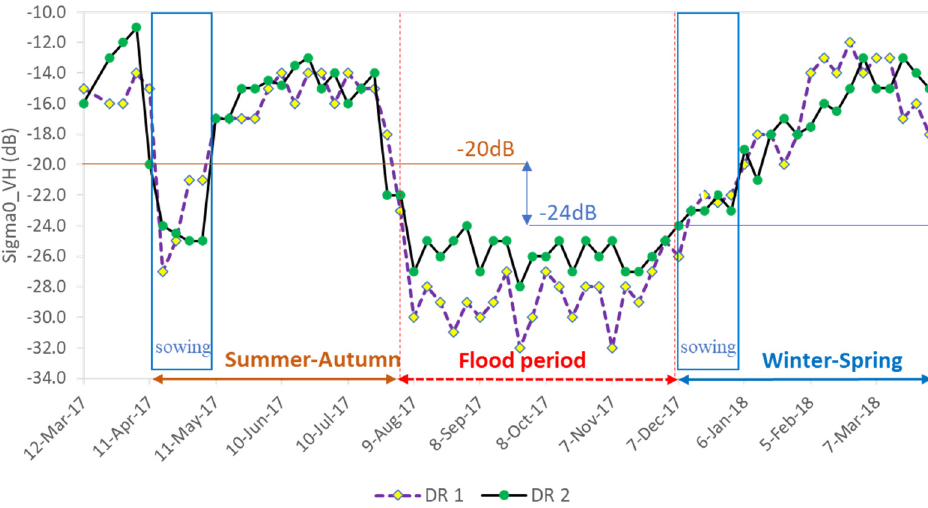
Figure 6. Sentinel-1 backscatter of crop phenology at two random samples, DR1 (10.47°N and 105.17°E) and DR2 (10.63°N and 105.51°E), cultivating two rice seasons a year (summer-autumn and autumn-winter seasons). The summer-autumn rice season is from April to July (right before the flood). The winter-spring rice season begins from December (right after the flood) to March. Another rice season could be possible in the flooding period from August to November for the areas that are protected by the dike system (autumn-winter season).